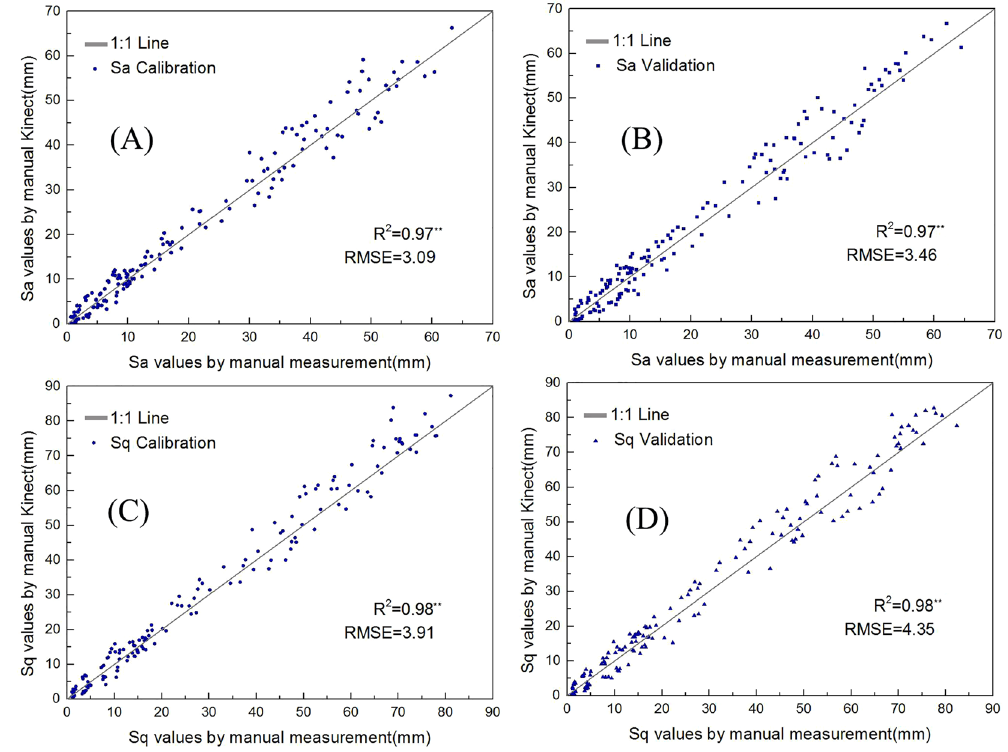
Figure 5. Comparison between the manual and Kinect measured value of Sa Calibration ( A ), Sa Validation ( B ), Sq Calibration ( C ), Sq Validation ( D ).